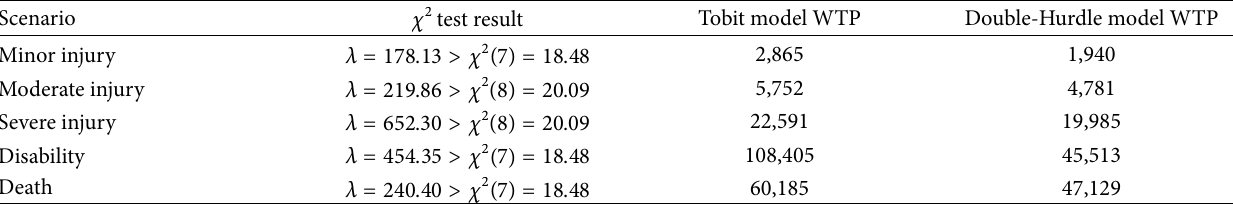
Table 6: Compare with Double-Hurdle versus Tobit